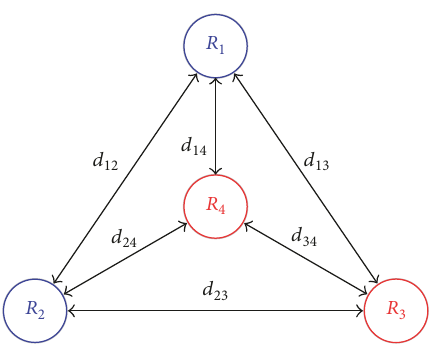
Figure 3: Simulation 1 setup of the distance-based formation control with 𝑛 = 4 and 𝑛 1 = 2 .